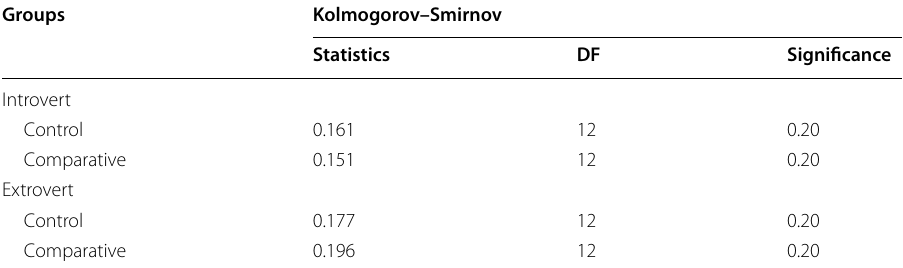
Table 1 The results of Kolmogorov–Smirnov test Groups